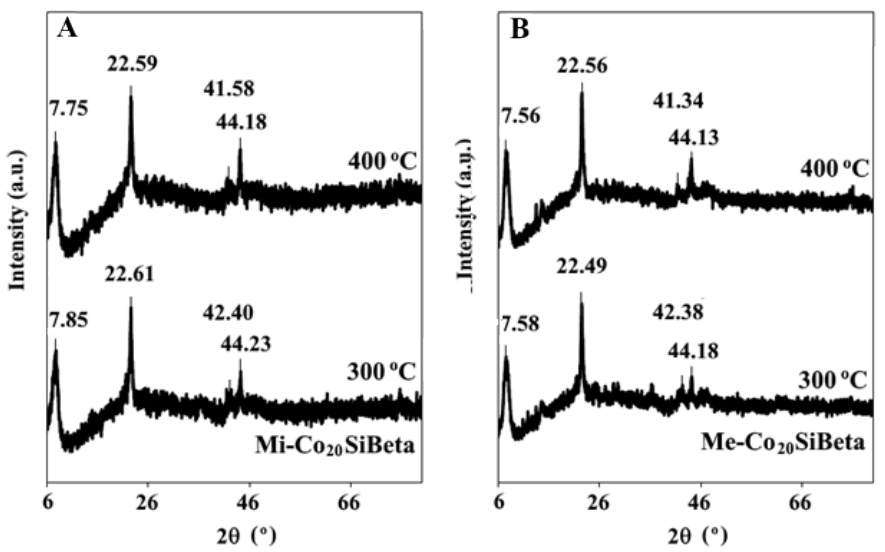
Figure 3. In situ XRD patterns recorded in situ at 300 and 400 o C measured in the atmosphere of the mixture of 5 vol % hydrogen in argon ( A ) Mi-Co 20 SiBeta and ( B ) Me-Co 20